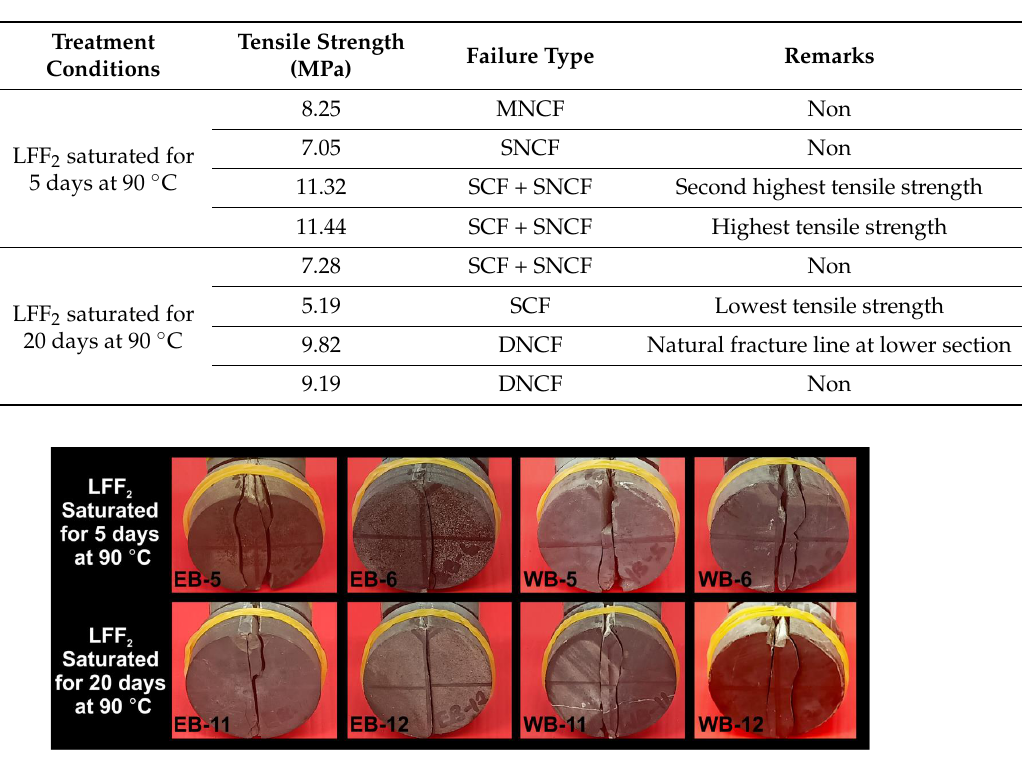
Figure 18. Tensile failure patterns that resulted from the samples subjected to LFF 2 saturation at 90 °C for the periods of 5 and 20 days prior to BITS testing. Figure 19a represented the tensile strength behaviors of Eagle Ford and Wolfcamp shale samples under different treatment conditions prior to BITS testing. In Figure 19b, the percentage decreases in mass resulting from the thermal exposure of the samples are presented. Among the Wolfcamp shale samples exposed to 90 °C, WB-13 for 5 days and WB-16 for 20 days had the highest and lowest values of tensile strength at 10.25 and 5.36 MPa, respectively. The percentage decreases in mass were 0.21% for WB-13 and 0.08% for WB-16 (Figure 19b). This implied that more pores were accessible to water phase dehy- dration in WB-13 exposed to 90 °C for 5 days, thereby causing a higher reduction in sam- ple mass, while fewer pores were accessible to water phase dehydration in WB-16 exposed to 90 °C for 20 days. Among the Eagle Ford samples exposed to 90 °C, EB-15 on 20 days of thermal expo- sure had the highest percentage decrease in mass at 0.55%, and EB-14 on 5 days of thermal exposure recorded the lowest percentage decrease in mass (0.14%) (Figure 19b). The